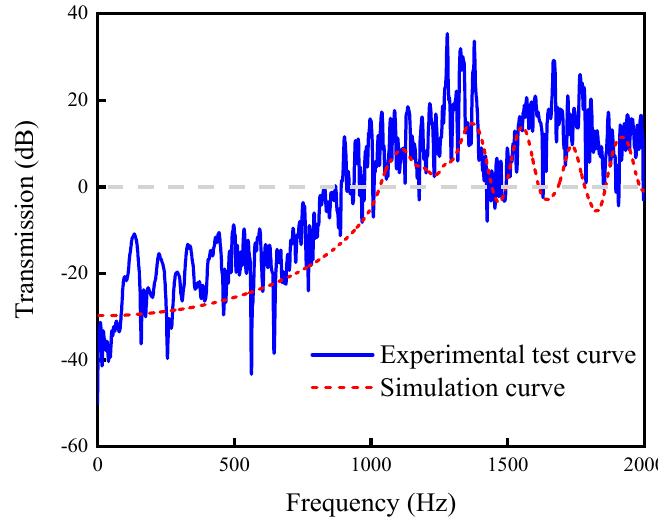
Figure 19. Specimen frequency response curve.